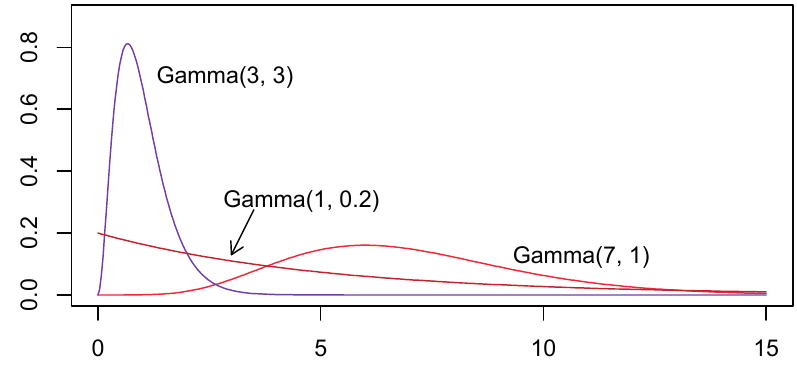
Figure A1. Probability density functions (pdfs) of the gamma distributions used in the